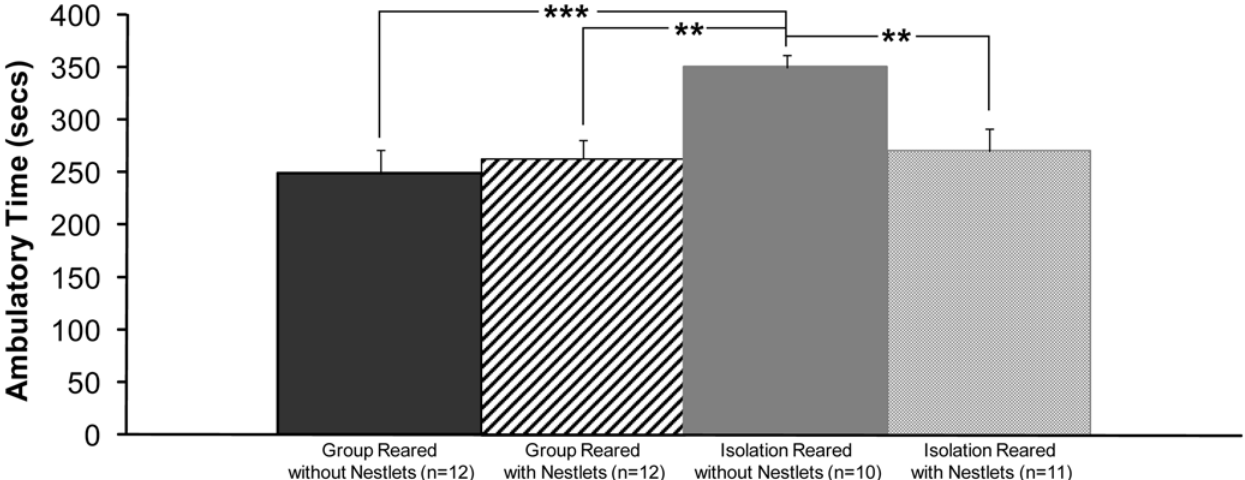
Figure 5. Effect of Nestlet treatment on open field test behavior. Ambulatory time was significantly lower for isolation reared rats treated with Nestlets (column 4) compared to untreated isolation reared rats (column 3) and not different from group reared rats (column 1) or group reared rats treated with Nestlets (column 2). Average 6 SEM.,* P , 0.05, ** P , 0.01, *** P , 0.001.